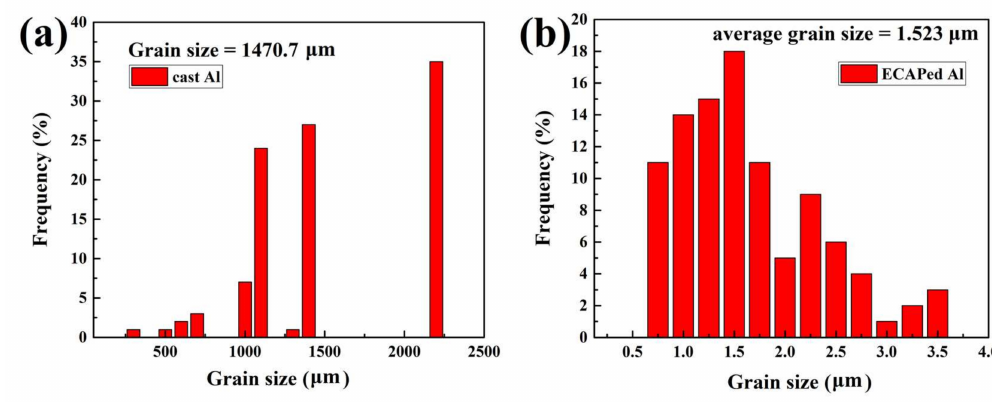
Figure 9. Grain-size distribution of the substrate sample: ( a ) cast sample and ( b ) ECAPed sample.